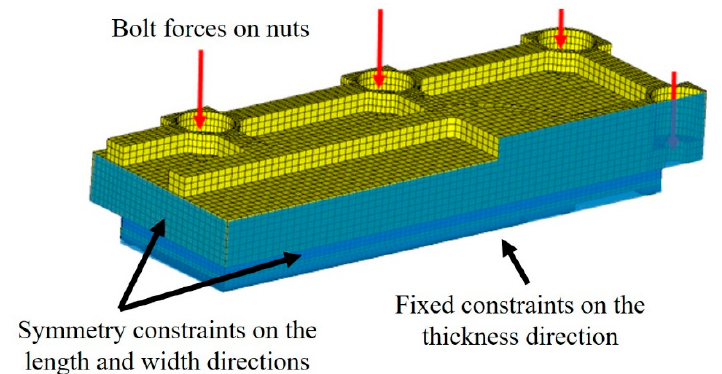
Figure 6. Boundary and loading conditions of the finite element (FE) model.